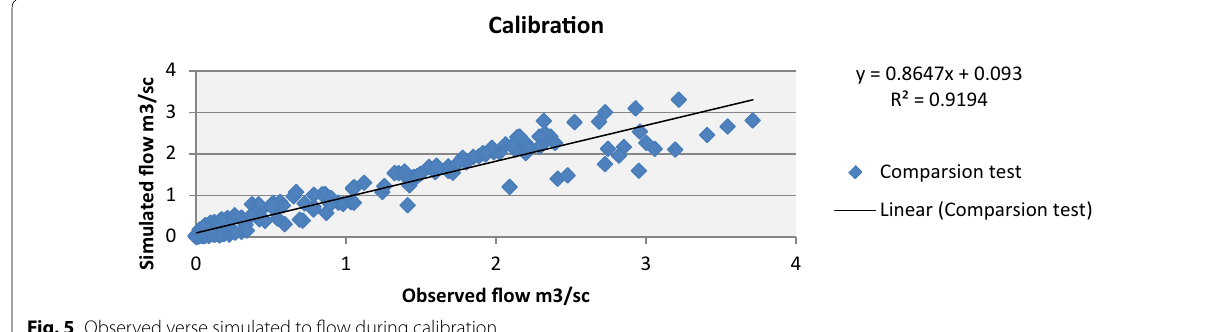
Fig. 5 Observed verse simulated to flow during calibration